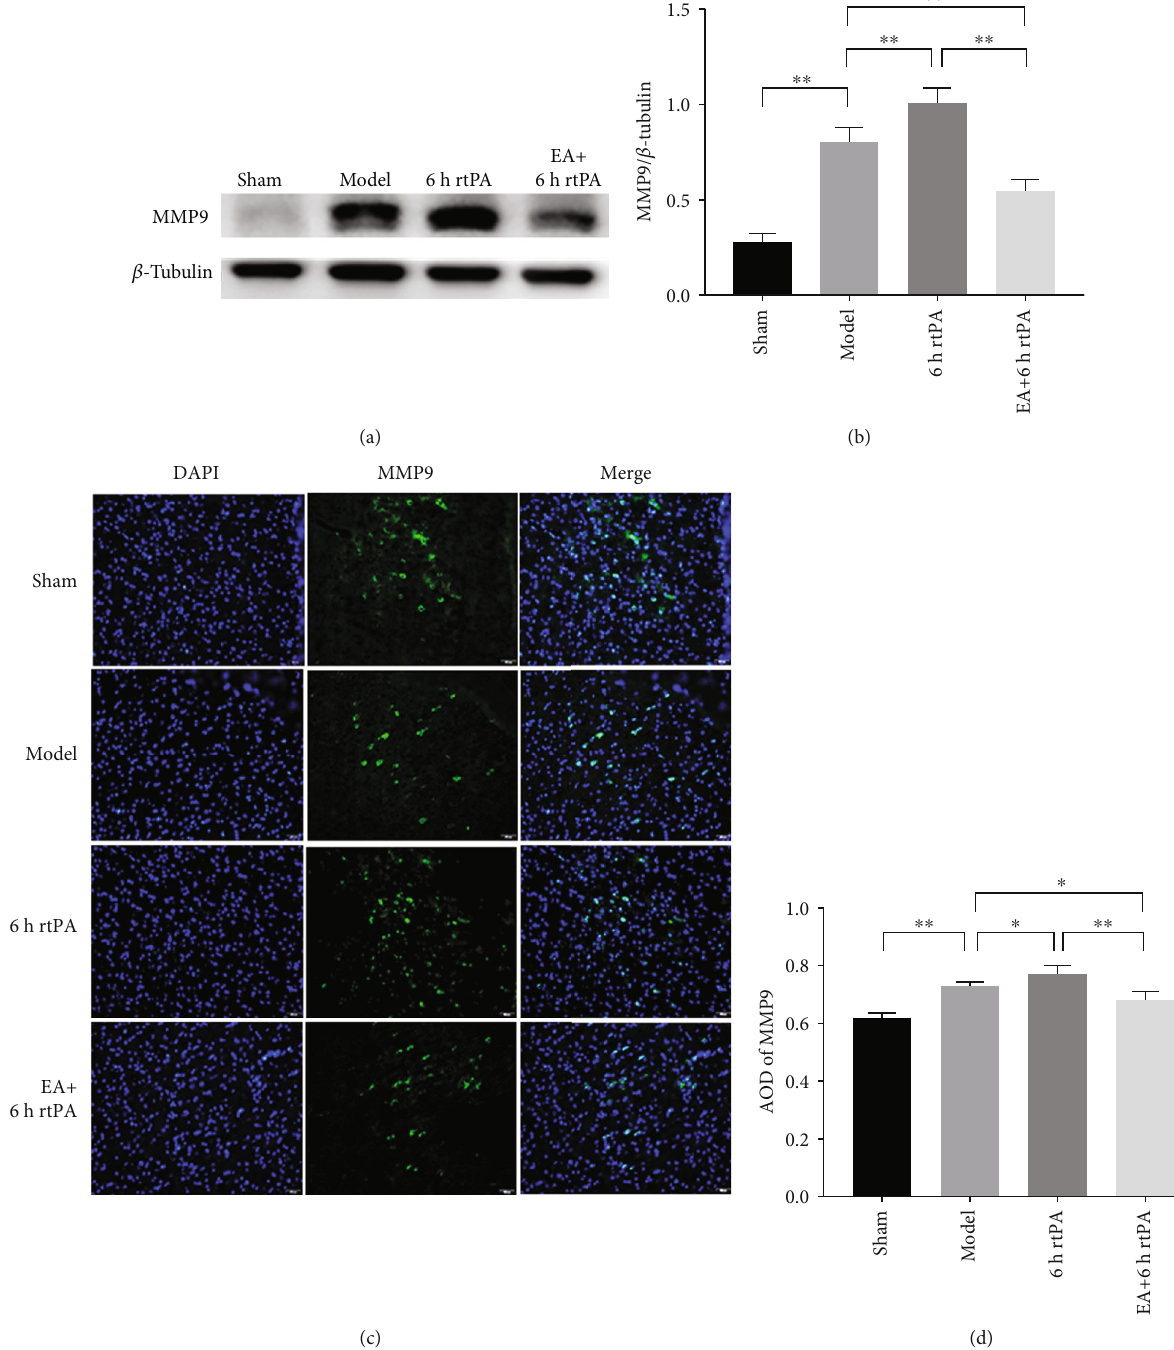
Figure 6: Western blot and immuno fl uorescence staining for MMP9 in each group ( n = 6 rats). (a) Representative immunoblot showing the levels of MMP9 in the ischemic penumbra area. (b) Relative levels of the MMP9 protein. (c) Representative images of MMP9 staining in the ischemic penumbra area. Bar = 50 μ m . (d) Average optical density of MMP9. ∗ indicates p < 0 : 05 ; ∗∗ indicates p < 0 : 01